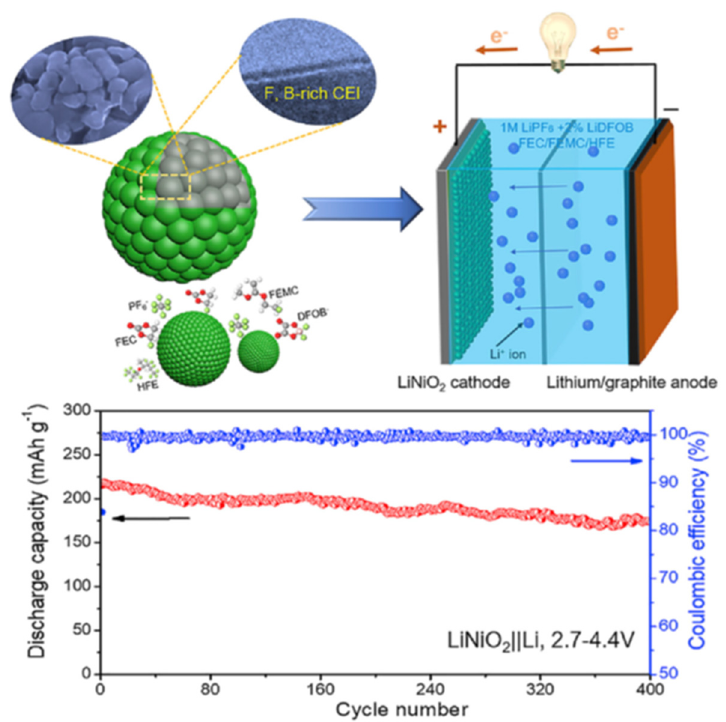
Figure 7. In situ formation of F and B-rich SEI layer on cobalt-free LiNiO 2 and long-term cycling ability and Coulombic efficiency over 400 cycles at 0.5 C. [95].